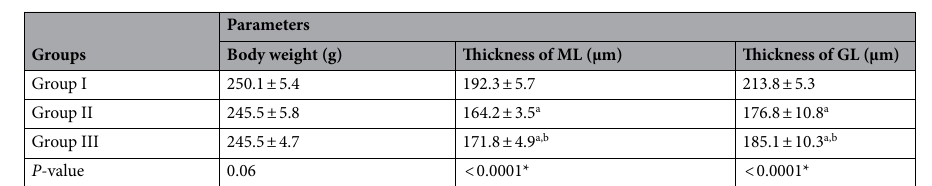
Table 1. Comparison of the body weight, the thickness of the molecular layer (ML) and the thickness of the granular layer (GL) in all studied groups. Data are represented as Mean ± SD. *Statistically significant difference. a Statistically significant as compared with the group I, P < 0.05 b Statistically significant as compared with the group II, P <